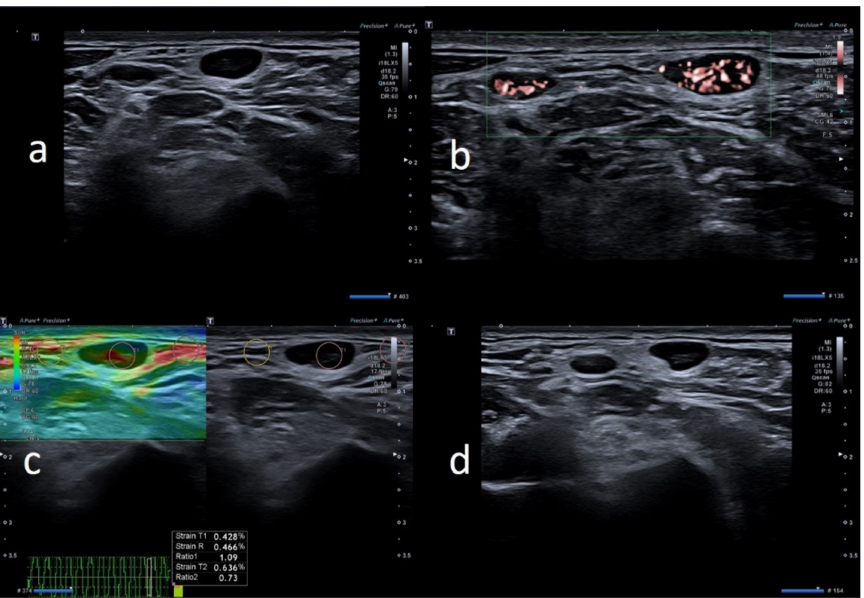
Figure 7. 41-year-old male with palpable unilateral sopraclavicolar adenopathy noted 3 days after receiving the first dose of the Moderna COVID-19 vaccine in his left deltoid muscle. ( a ) B-mode sonogram image shows 2 ovular hypoechoic lymph nodes with hilum absence. ( b ) SMI image shows central and peripheral vascularization ( c ) Elastonography strain shows similar pattern of the node compared to surrounding tissue. ( d ) After 1 month, the cortical thickening appears uniform with hilum evidence.